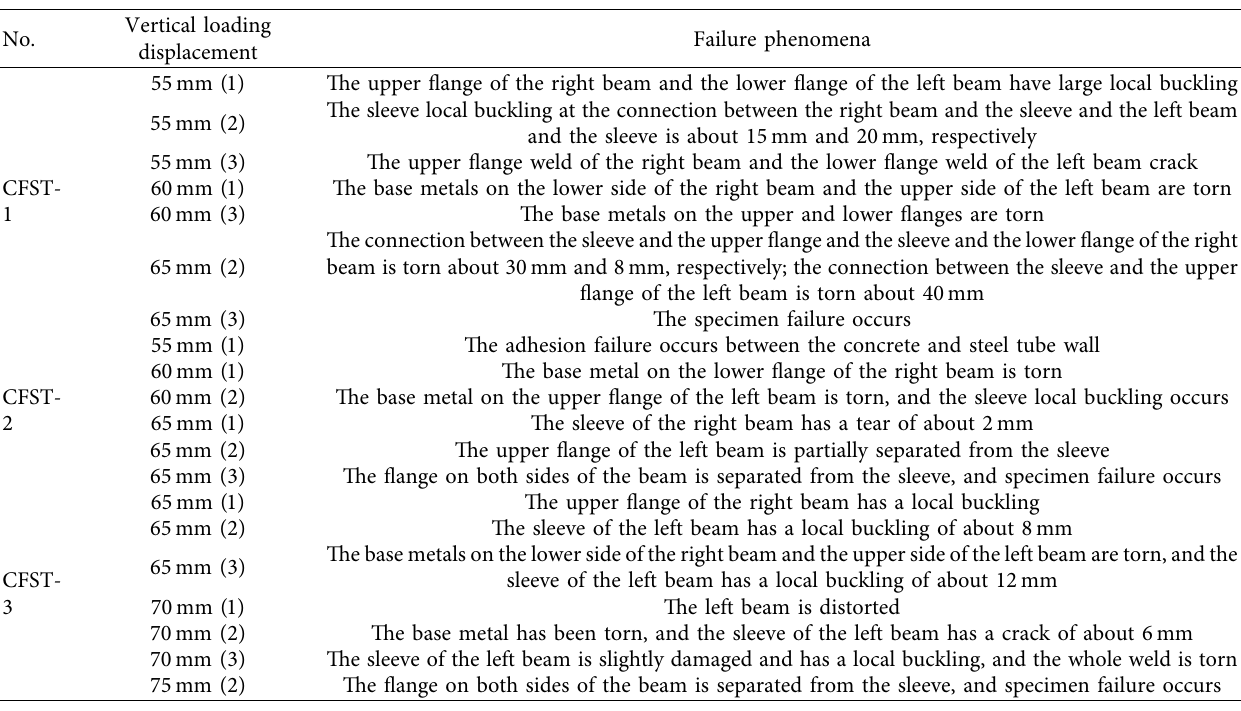
Table 3: Failure phenomena of